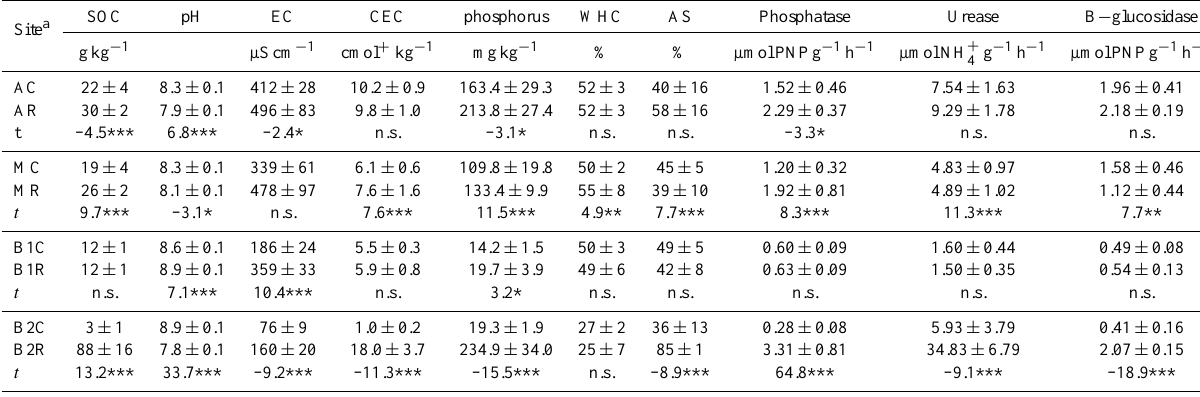
Table 3. Mean values ± standard deviation and t-student values of the soil properties for each site. Site a